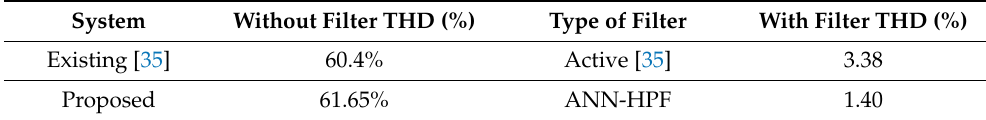
Table 2. Comparative performance of the current using various filters.